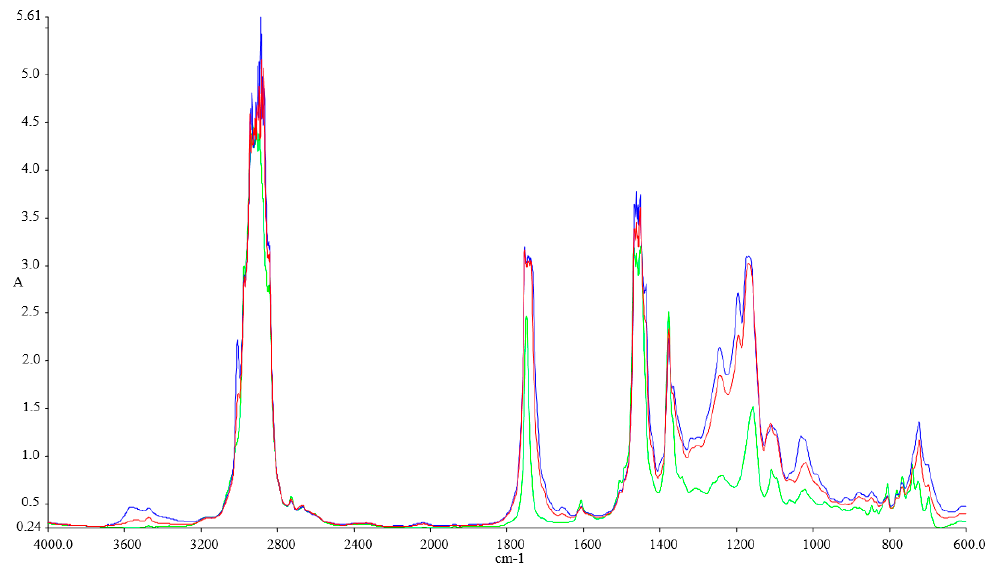
Figure 4. FTIR spectra of the tested fuel blends: Green-Ke, Blue-Ke+50%SF, and Red–Ke+50%SFP. The FTIR spectra inspected for the blends show variations at 1745.83 cm − 1 (C=O stretching), 1030.98 cm − 1 , 1117.54 cm − 1 , and 1170.23 cm − 1 (C–O alkoxyl stretching), they are